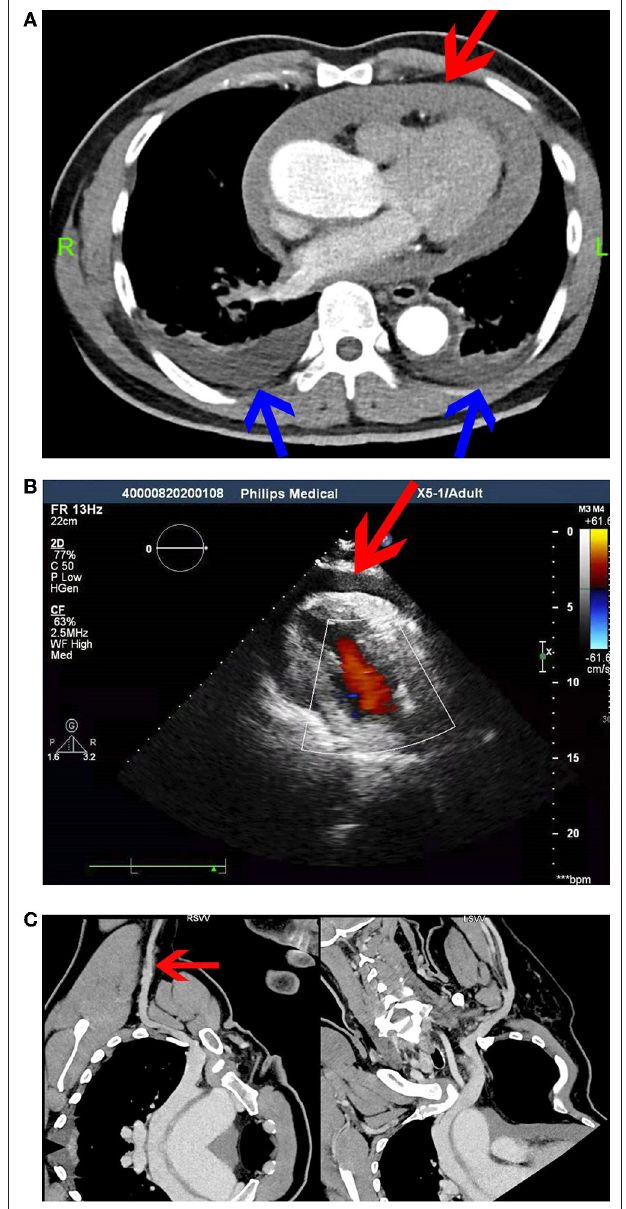
FIGURE 2 | (A) Computed tomographic pulmonary angiography (CTPA). Pericardial effusion or hemorrhage (red arrow) and a small volume of pleural effusion (blue arrow) were observed. (B) Echocardiography at 12h after SVCF removal. (C) Computed tomographic venography (CTV) of the upper limb vein. The right axillary vein was not filling well (red